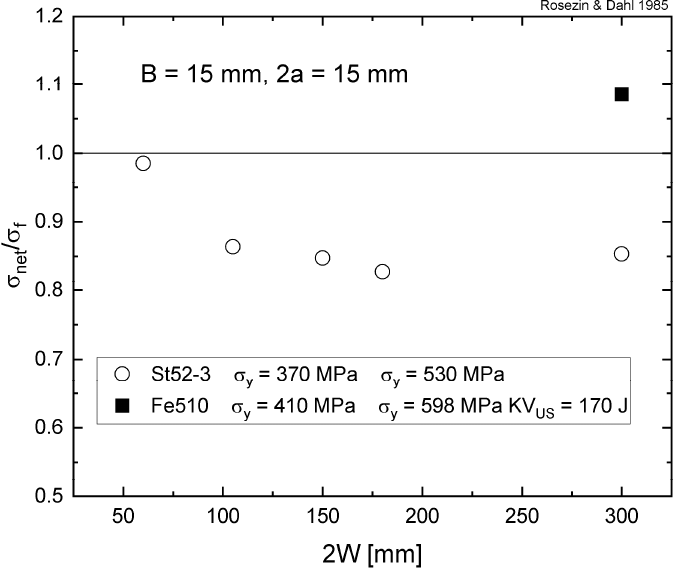
Figure 17. Proportional net section stress as a function of specimen width for 15 mm thick specimens with fixed flaw size, 2a = 15 mm [11,12].